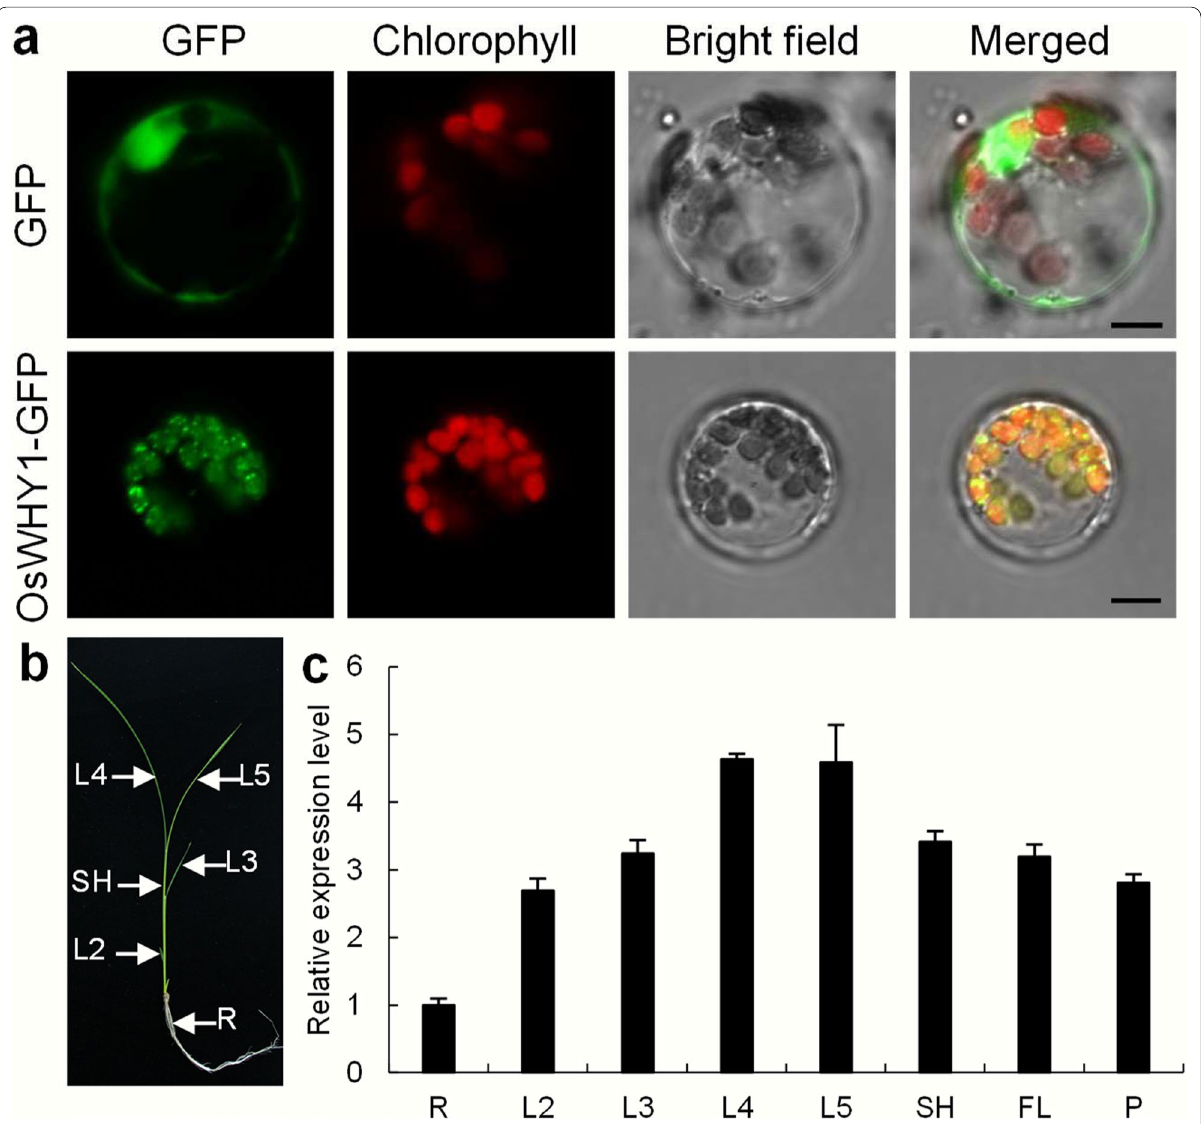
Fig. 4 Subcellular localization and expression analysis. a Subcellular localization of OsWHY1. Free (GFP) and OsWHY1-GFP fusion protein in rice protoplasts were photographed under a confocal microscope at 488 nm. Bar 5 μm. b, c OsWHY1 expression levels in different tissues of the WT = seedlings. L2-L5, the second to the fifth leaves; SH, leaf sheath; R, root; FL, flag leaf; P, panicle. The OsWHY1 transcript levels in the root were set to 1. Data are the mean SD (n 3). ** p < 0.01 (Student’s t ± =